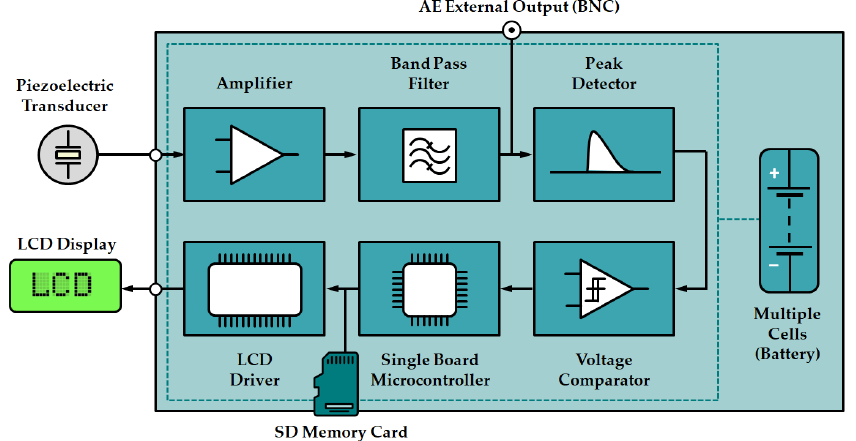
Figure 1. Schematic diagram of a low-cost online partial discharge monitoring system.